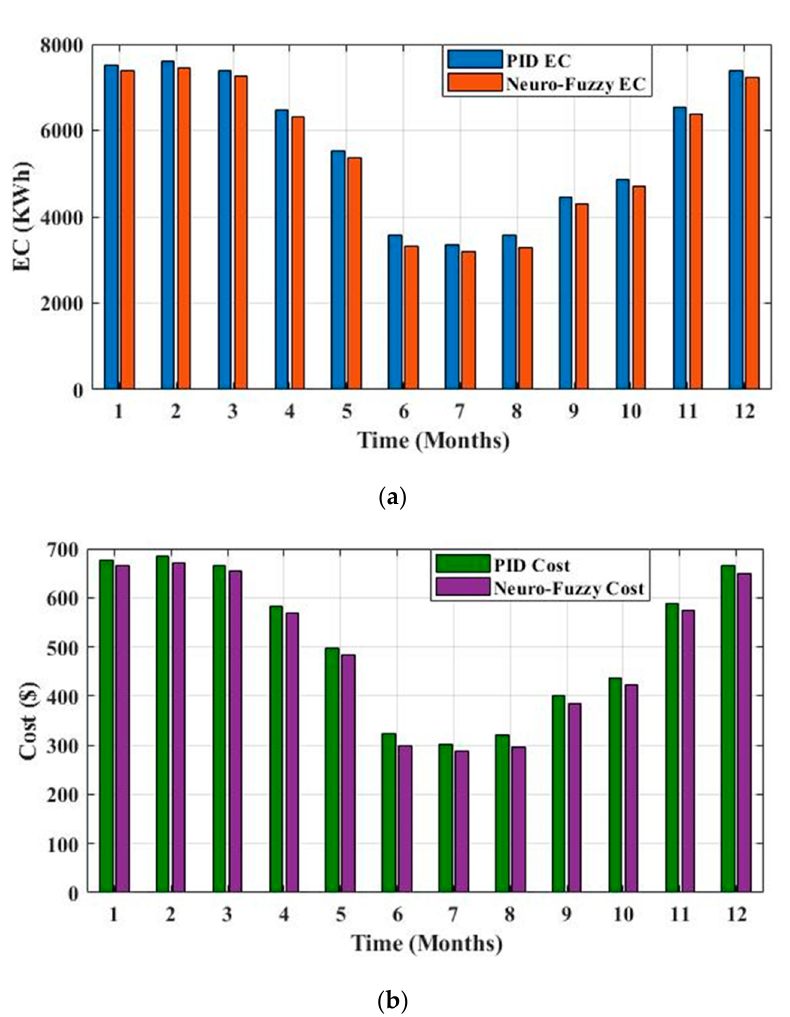
Figure 10. ( a ) EC and ( b ) energy cost of PID and adaptive NF-II control